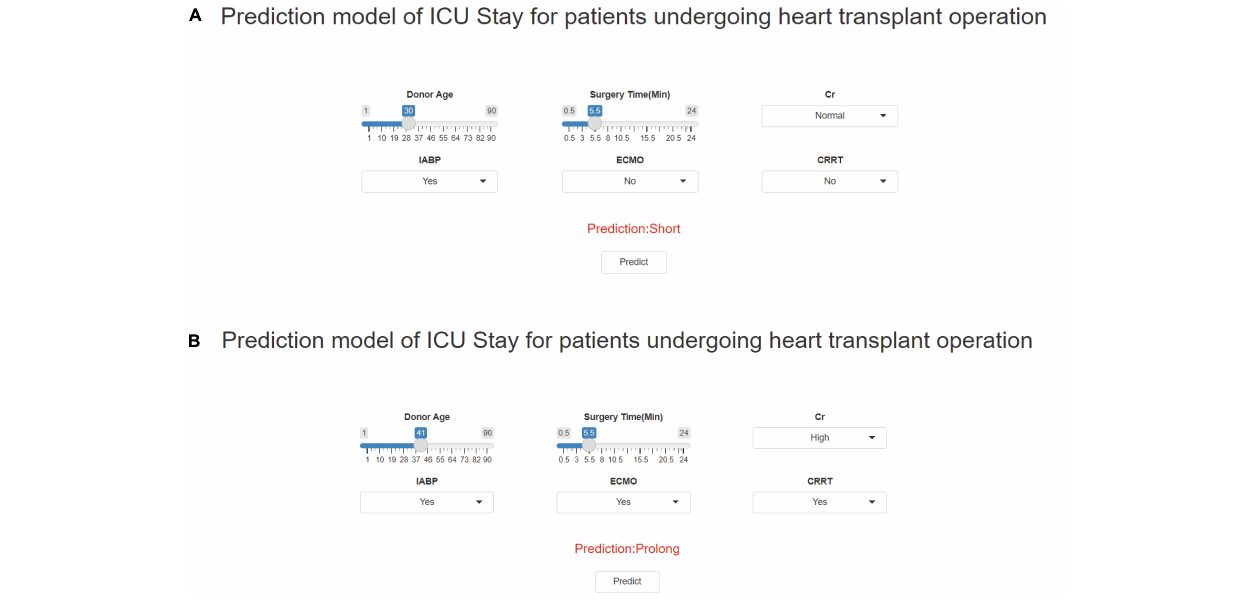
FIGURE 7 | Outcomes were generated by the prediction tool for two fictitious case scenarios. Enter the values of six key variables to predict the risk of ICU-LOS. (A) Has a short ICU-LOS and (B) Has a prolonged ICU-LOS.